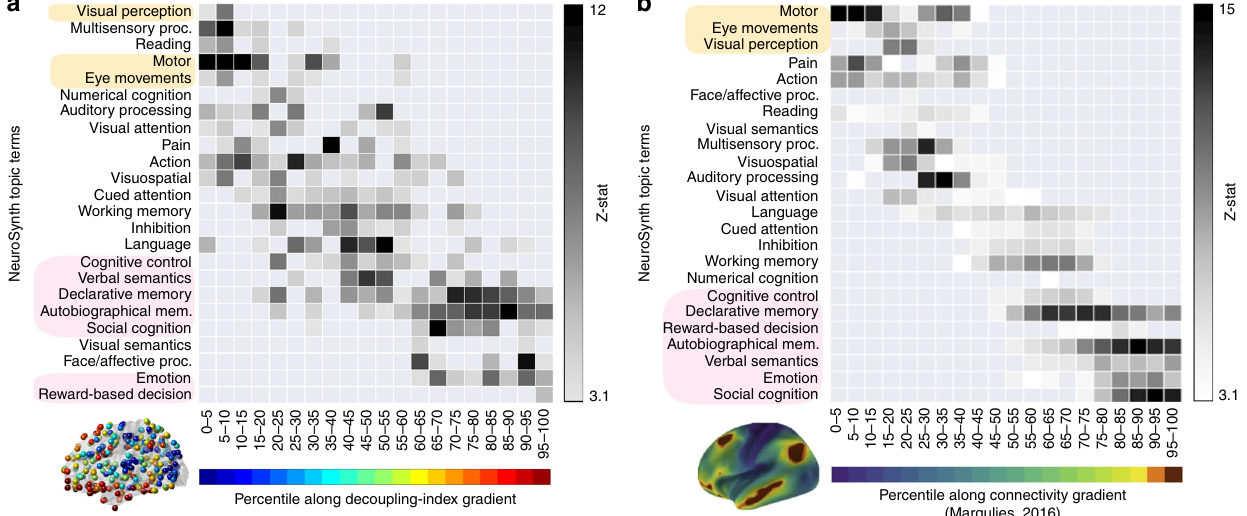
Fig. 3 Structural-decoupling index reveals organization according to a behaviorally relevant gradient. a NeuroSynth meta-analysis is applied to the decoupling index gradient; b similar analysis conducted in ref. 30 on a functional connectivity gradient (right). Our analysis shows for the fi rst time that the strength of structure – function coupling orders regions according to behavioral relevance, in accordance with other known principles of brain organization. In fact, despite the two analyses have a different input, a similar trend is found, correlating regions at one extreme of the gradient to lower-level sensory – motor functions and regions at the opposite extreme to higher-cognitive functions. The regions found at the extremes in ref. 30 are highlighted in both diagrams. Source data to reproduce a are provided as a Source Data fi le. b Adapted with permission from Fig. 4 in ref.